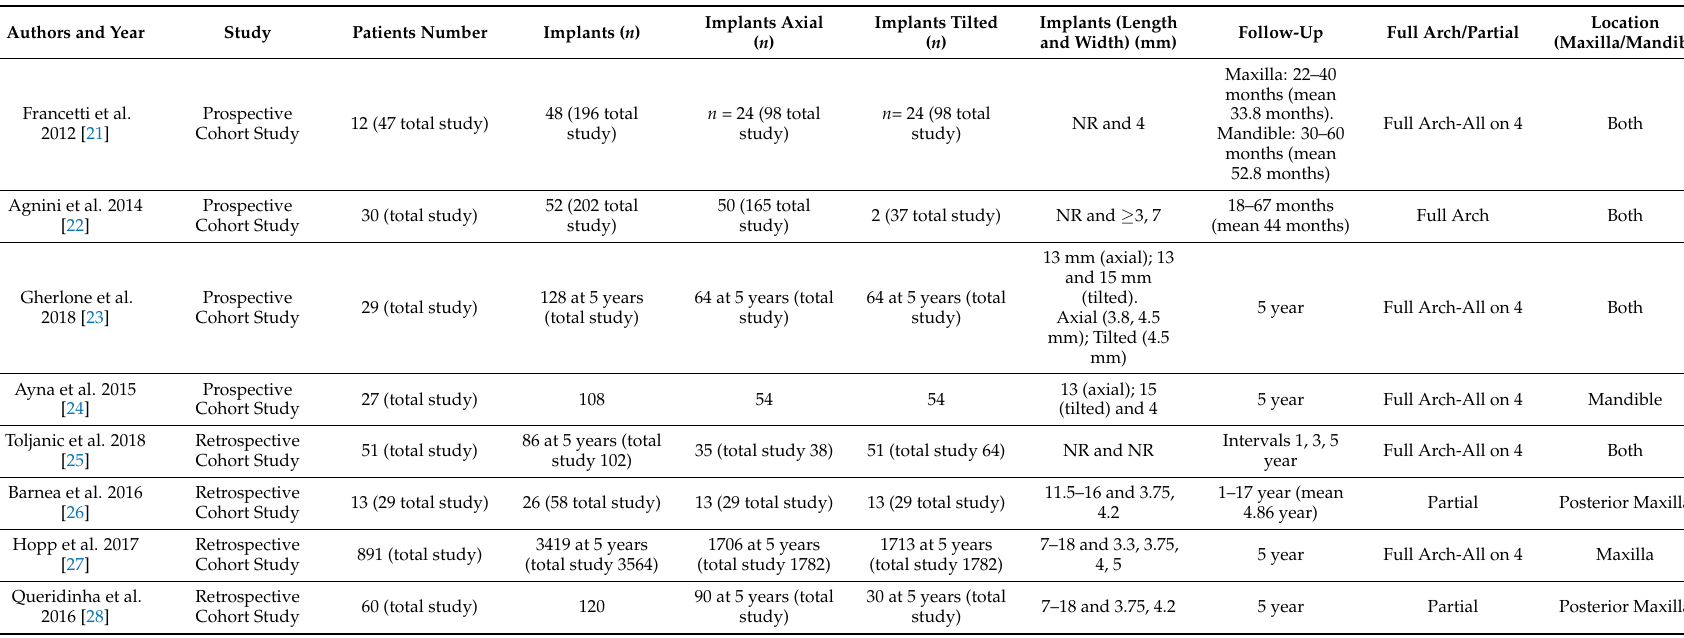
Table 1. Information about studies reviewed, evaluating straight implants compared with tilted implants supporting fixed restorations: study, sample size, implant number, follow-up, location, and rehabilitation